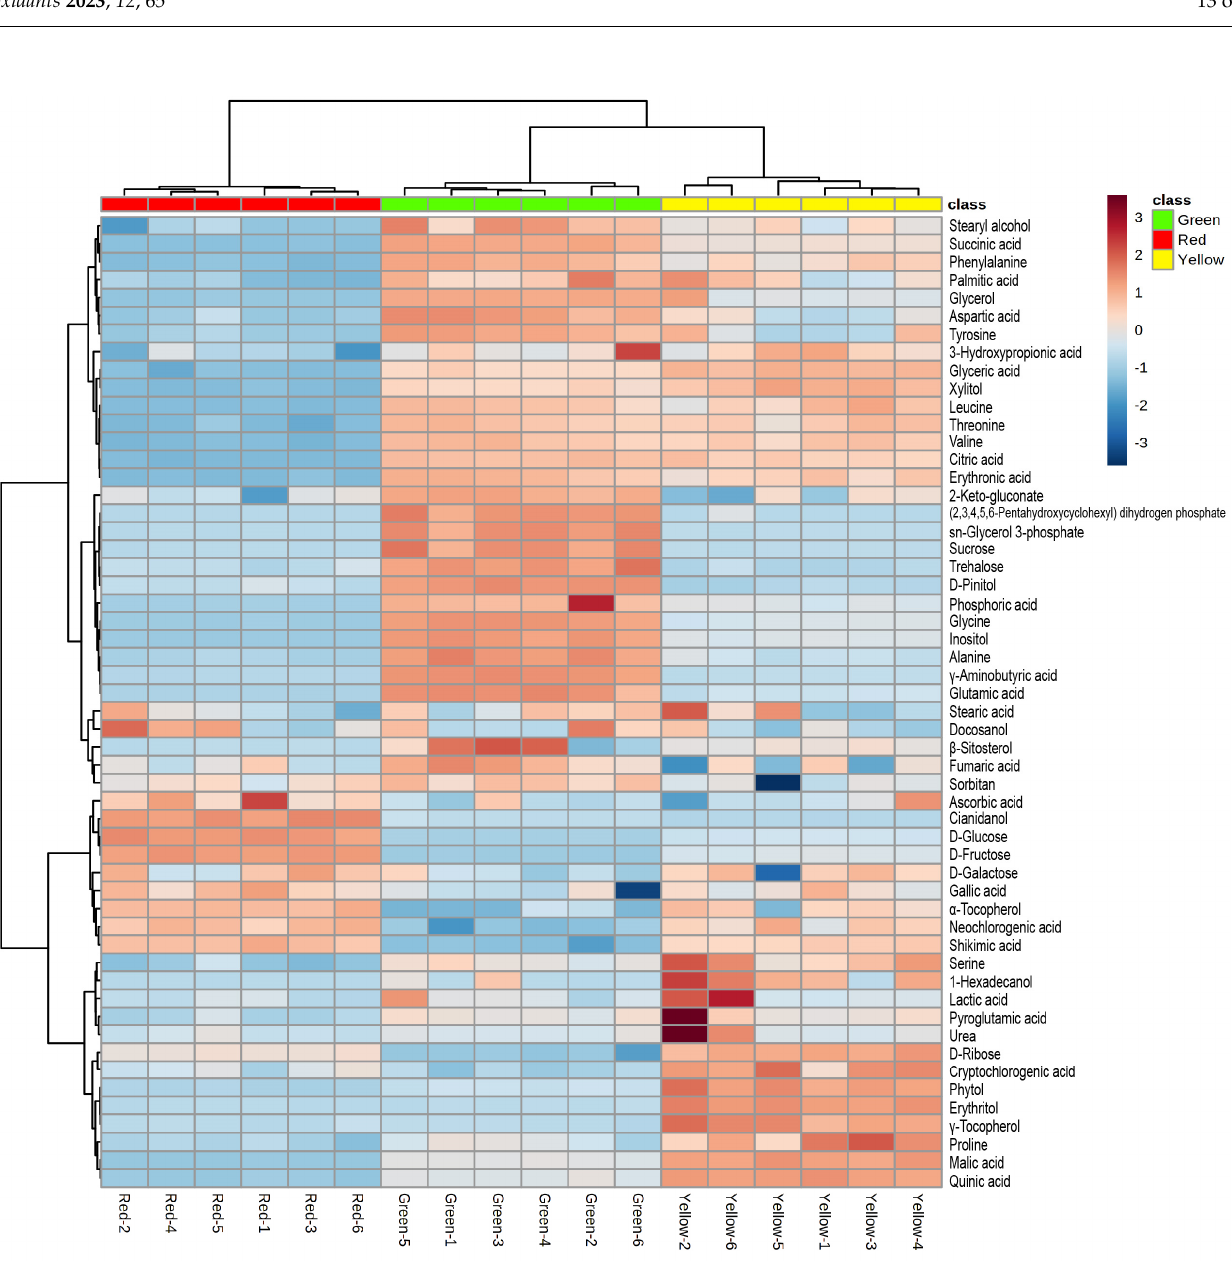
Figure 5. Heatmap from hierarchical clustering analysis (HCA) of maple leaves with different col- ors.